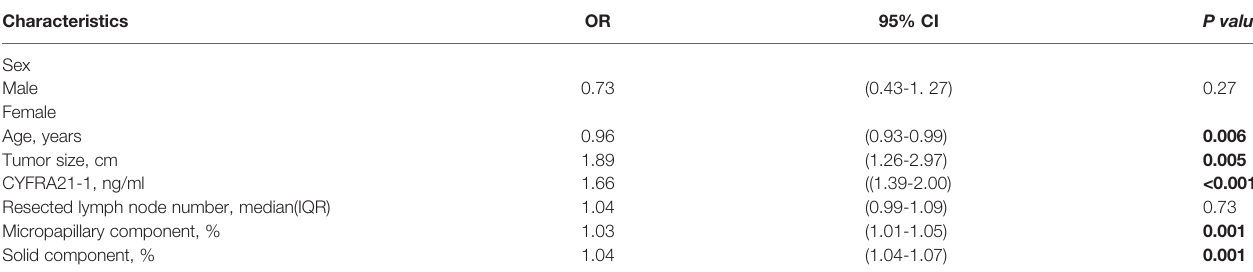
TABLE 2 | Univariate logistic regression analysis of the OLNM risk.